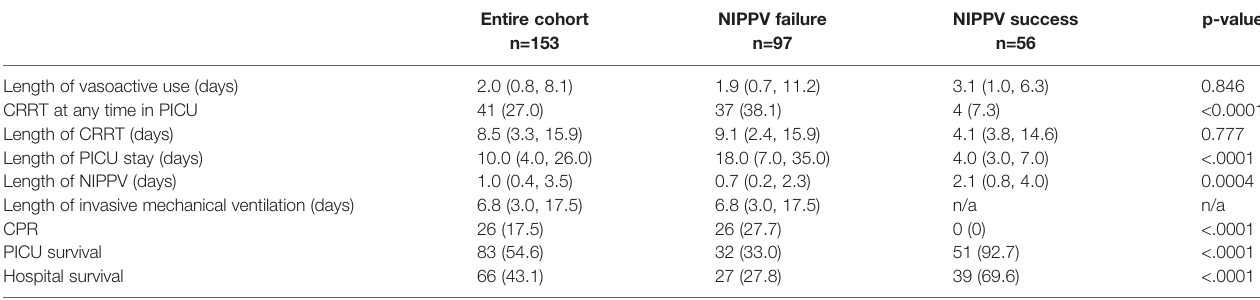
TABLE 4 | Critical care interventions and outcomes of the cohort assessed by NIPPV failure status.